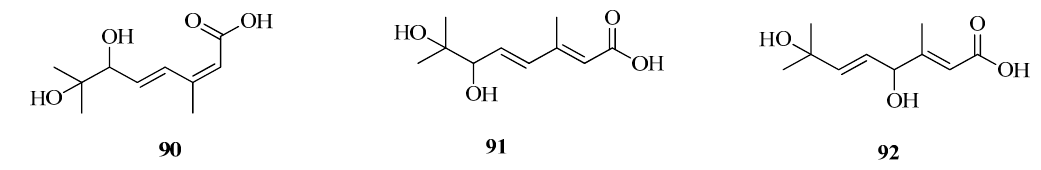
Figure 7. Structures of fatty acids isolated from F. esculentum , F. tataricum and F. diabotrys .